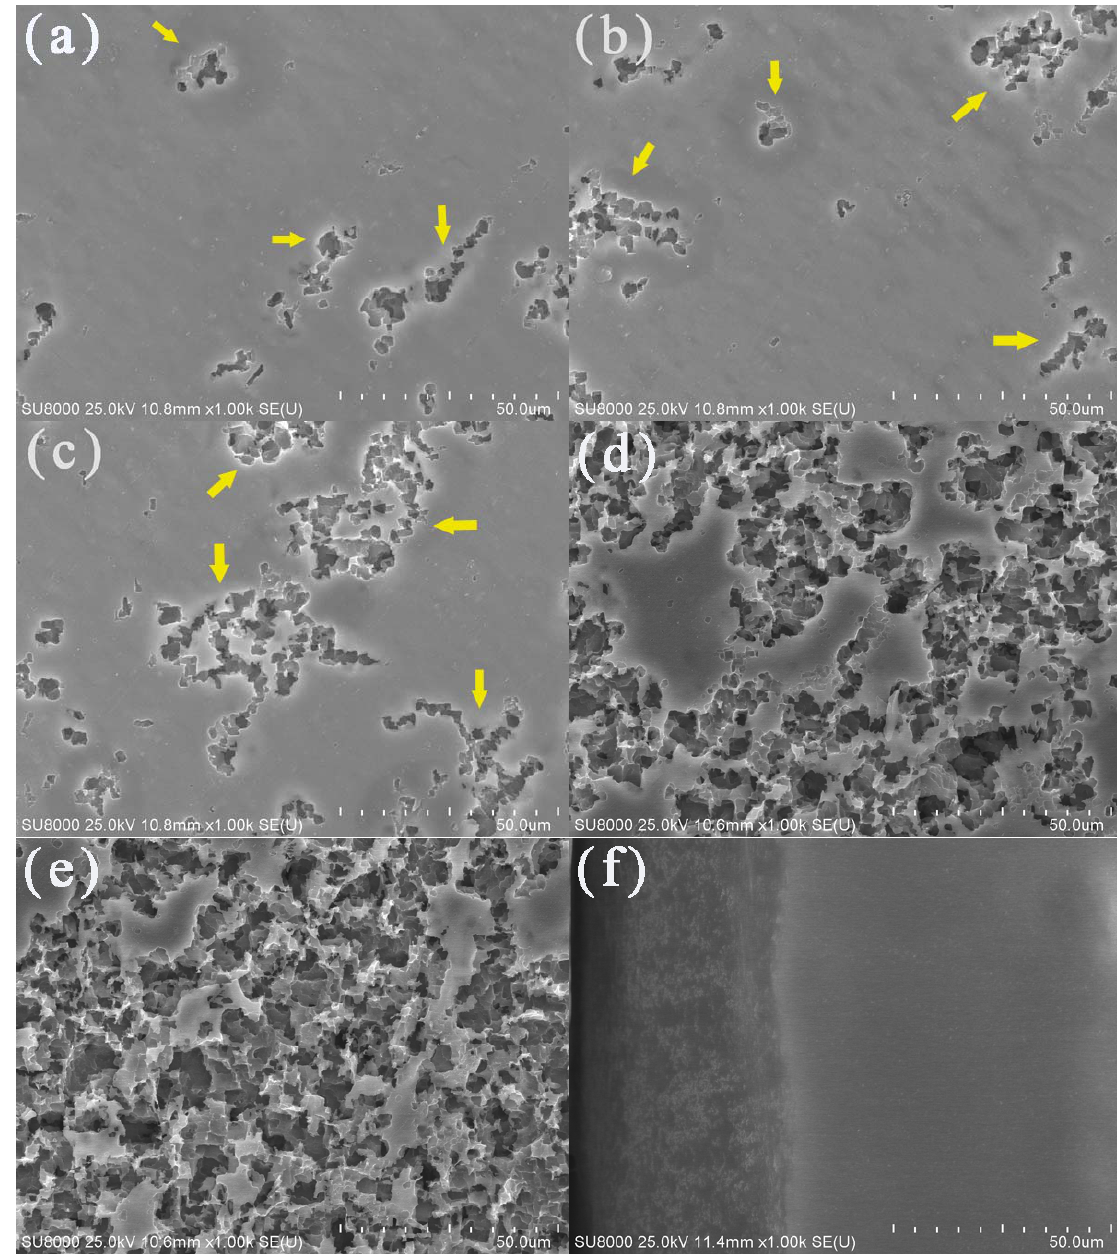
Figure 4. SEM images of the aluminum electrode surfaces in deionized water at 10 ( a ), 20 ( b ), 30 ( c ), 40 ( d ), and 50 °C ( e ) and the cross ‐ section of the aluminum electrode after a constant voltage corrosion of 0.5 V for 0.5 h in 50 °C deionized water. The yellow arrows referred to the gullies and pits.